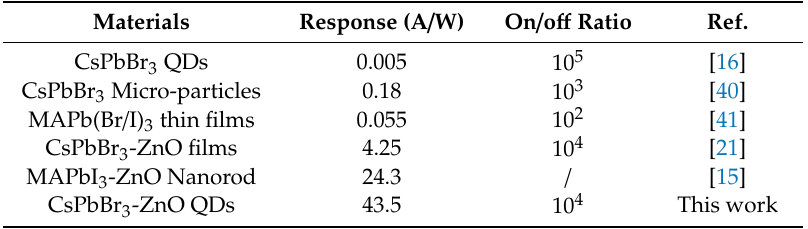
Table 1. Performance comparisons of the prepared perovskite